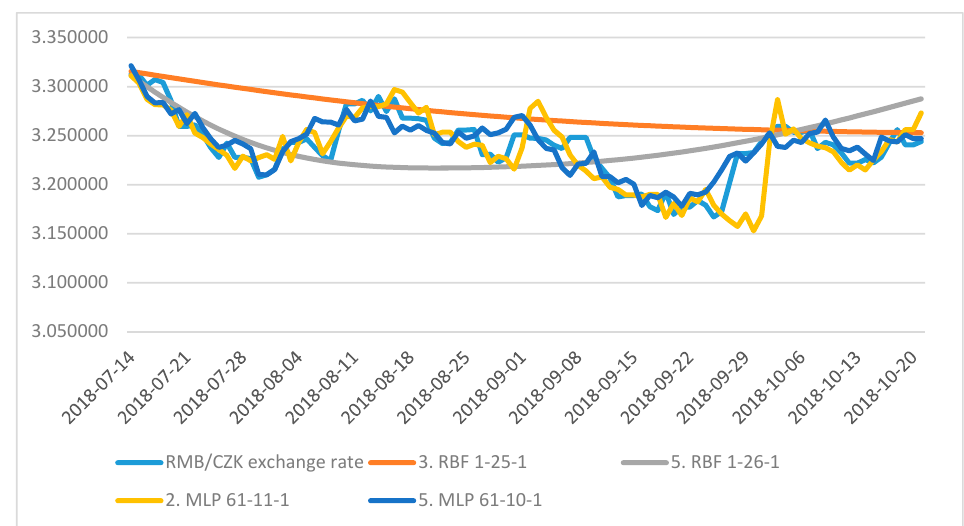
Figure 9. Comparison of selected neural networks for equalized time series for thee CZK/RMB exchange rate during the period from 14 July to 21 October 2018 (Source: Own research). A number of other authors have also dealt with the prediction of exchange rates using ANN. Although their findings are interesting, they deal with a partially different application than the one addressed in this contribution.